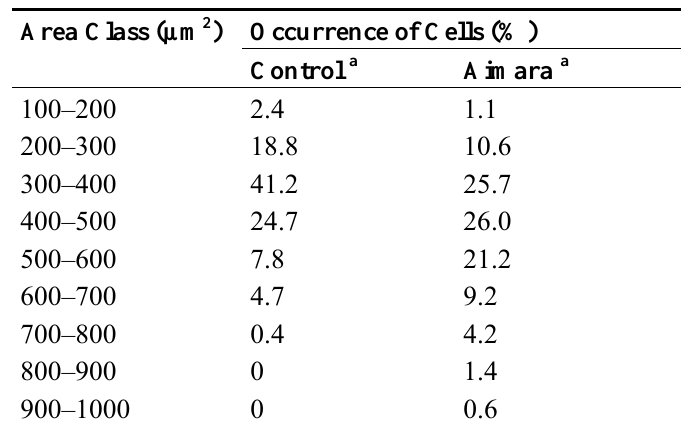
Table 12. Distribution of hepatic cell areas in mice fed aimara-containing diet for 7